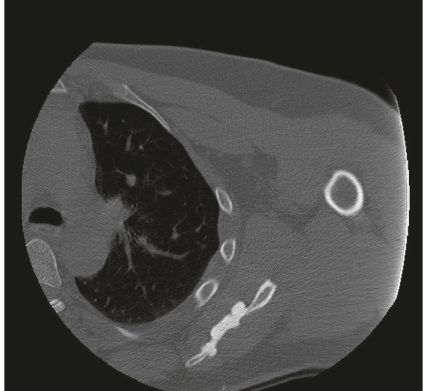
Figure 2: Computed tomography scan of the left shoulder. Axial cut showing hyperostotic masses dribbling from the scapular